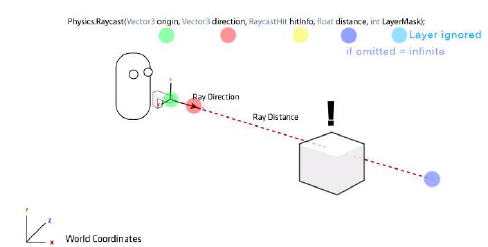
Figure 6: Rays in Unity 3D ( Source: Unity Girl Developer)